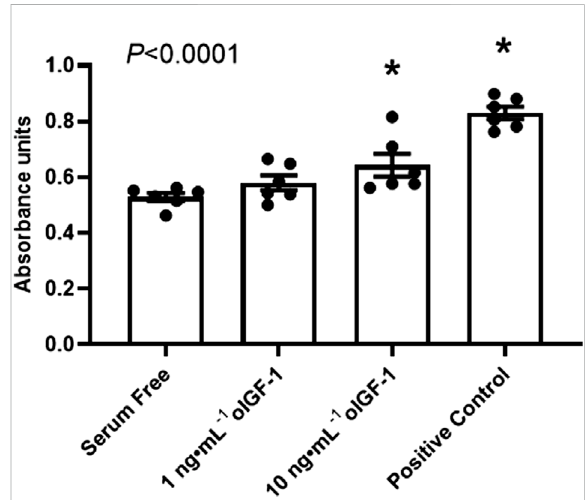
FIGURE 2 Myoblast proliferation in vitro . Myoblasts harvested from biceps femoris muscle from normally growing late gestation fetal sheep(n=6)wereexposedtoserumfreeDMEMor1or10 ng · mL − 1 of recombinant ovine IGF-1 (oIGF-1) in DMEM for 72 h. Myoblasts were also exposed to DMEM with 10% FBS as a positive control. Myoblast proliferation was measured using 3-(4,5- dimethylthiazol-2-yl)-2,5-diphenyl tetrazolium bromide (MTT) assay.Signi fi canteffectbyone-wayANOVAisindicated.*Indicates signi fi cantly different ( p ≤ 0.05) from serum free DMEM by Bonferroni ’ s post hoc